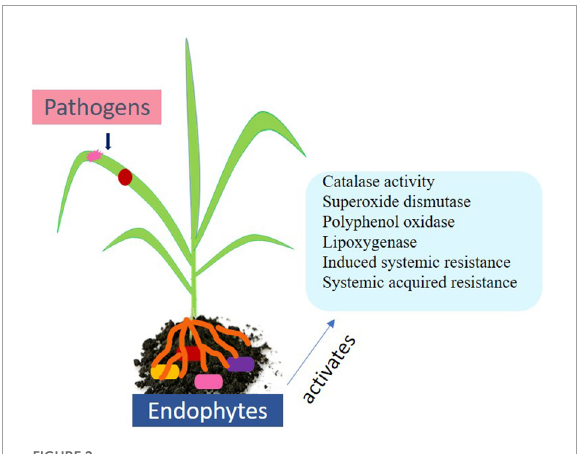
FIGURE2 Endophytes and their role in biotic stress